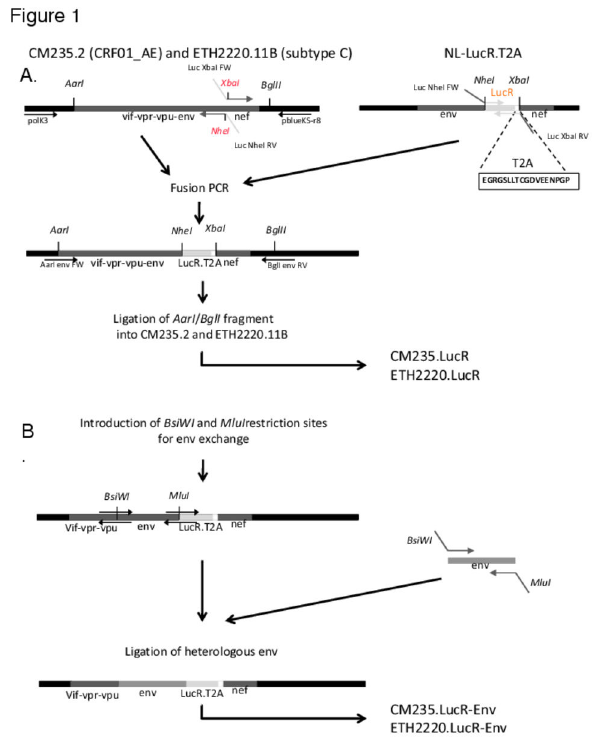
Figure 1. IMC.LucR construction. Schematic representation of the construction of (A) primary isolate-derived IMC.LucR and (B) chimeric